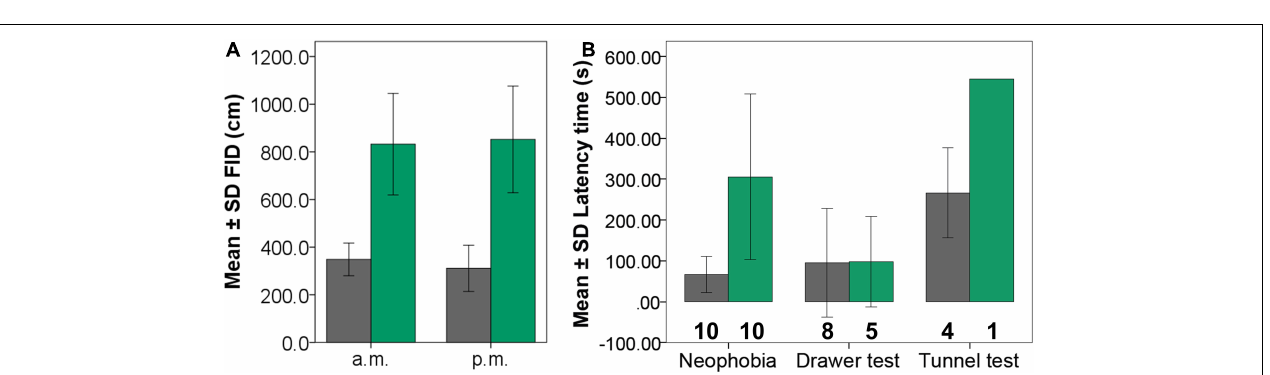
FIGURE 2 | Comparison between urban (gray bars) and extra-urban (green bars) individuals of Chiguanco Thrush in the city of Paz for flight initiation distance (FID) (A) and for performance in the neophobia test and two problem-solving tests (drawer test and tunnel test) (B) . In (A) the comparison between the morning (a.m.) and the afternoon (p.m.) is included, and in (B) the numbers below the bars show the total number of individuals who were able to solve the tests (out of a total of ten per